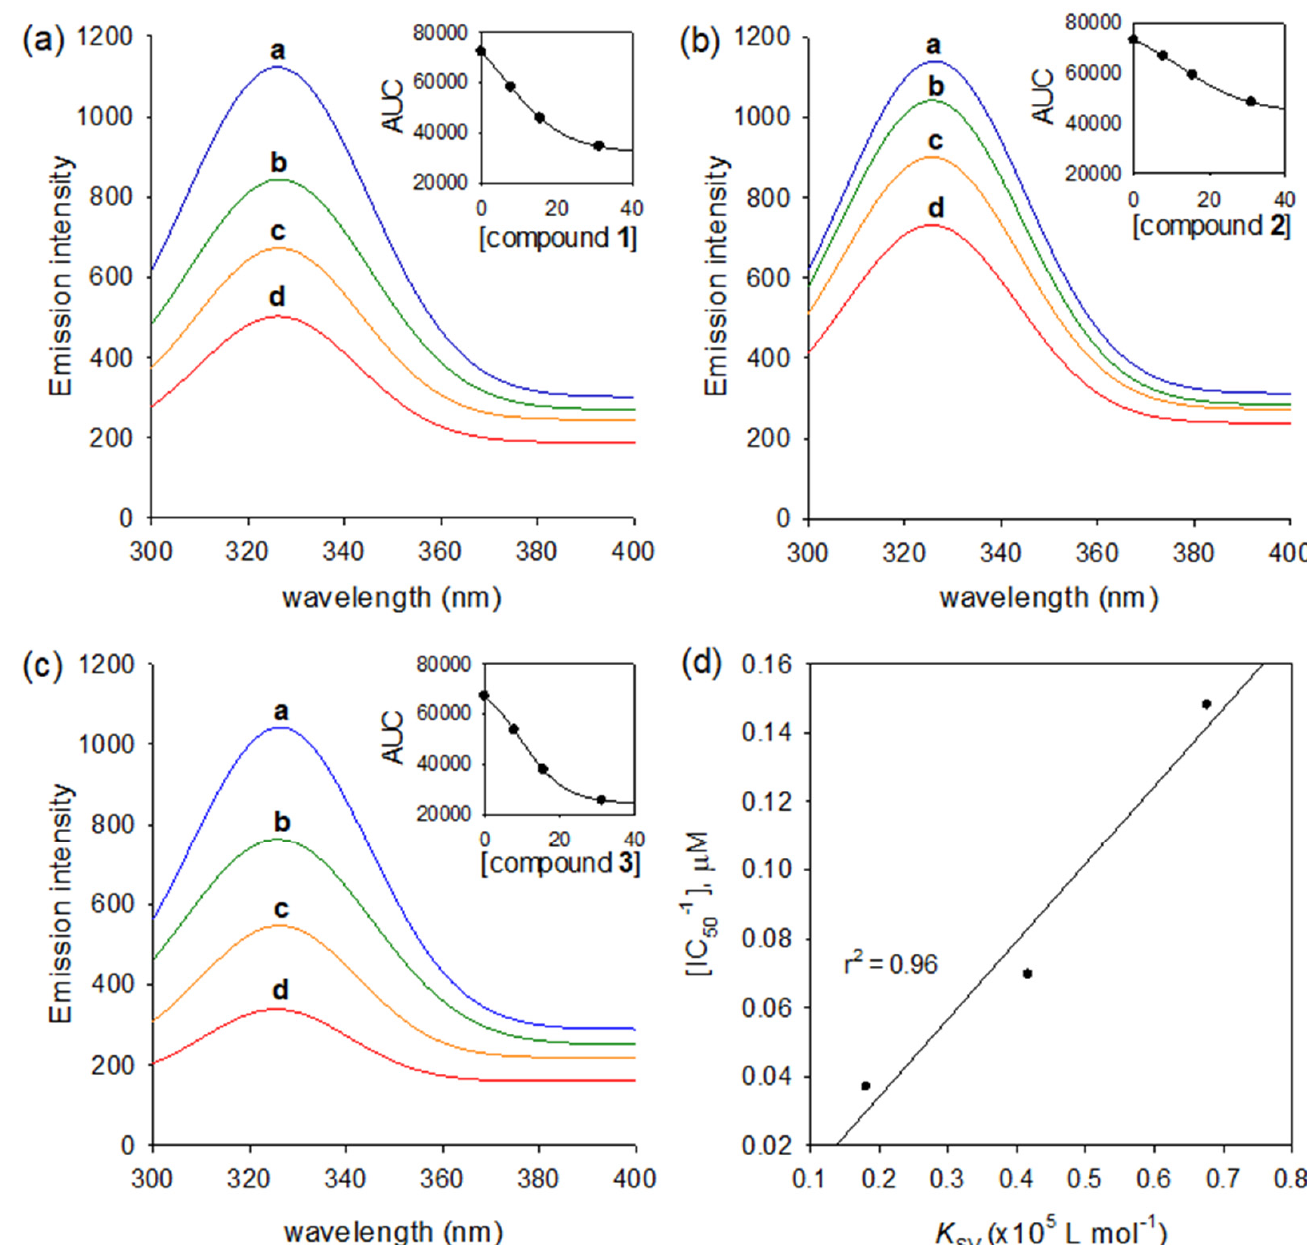
Figure 4. Binding affinities of isolated iridal-type triterpenoids on HNE. ( a – c ) The fluorescence emission spectra of HNE at different concentrations of compound 1 , 2 , and 3 (0, 7.8, 15.6, and 31.2 µM for curves from a to d). ( d ) The correlation between half maximal inhibitory concentration (IC 50 ) values and Stern-Volmer constants ( K sv) of compounds 1 – 3 . Table 2. Evaluation of Stern–Volmer constants regarding fluorescence quenching effects of HNE inhibitors 1–3 .